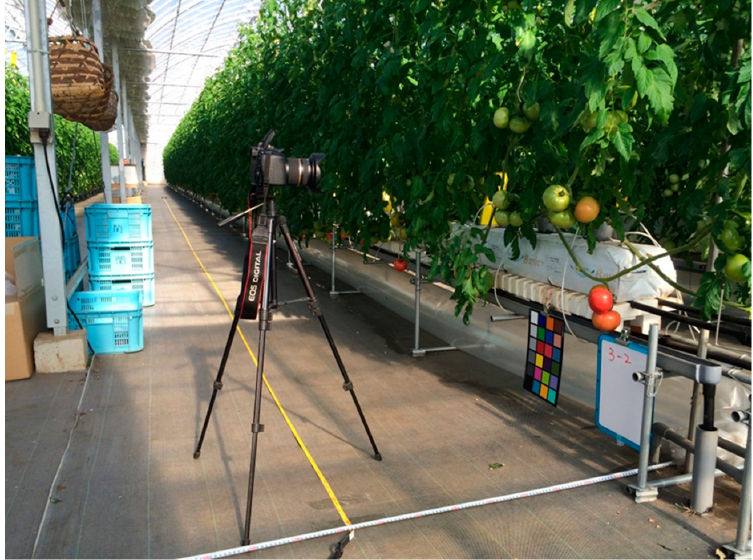
Figure 1. The camera layout for taking tomato photos in the greenhouse of Seki farm. Table 1. Details of the dataset.